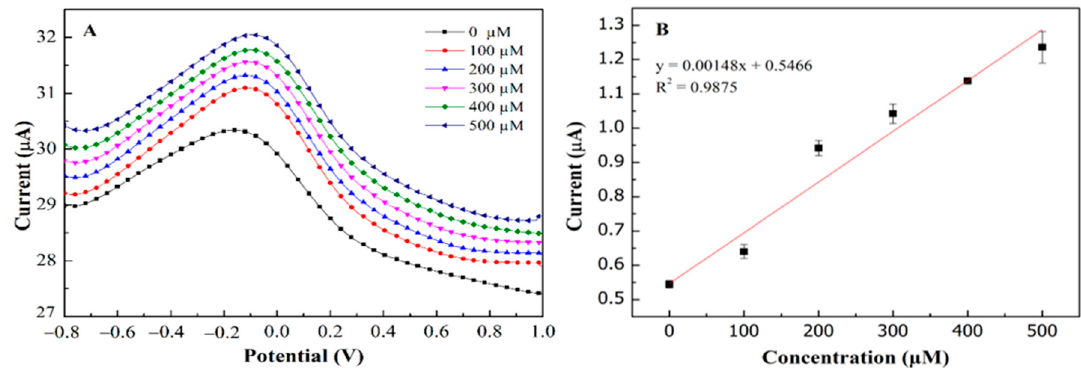
Figure 7. The concentration of glucose detection with linear range 0 − 500 µ M at SPCE/PEDOT: PSS/Ti 3 C 2 /GQD − GOx, ( A ) DPV analysis for 0–500 µ M of glucose; ( B ) linearity of glucose concentration vs. current oxidation peak (Ipa).